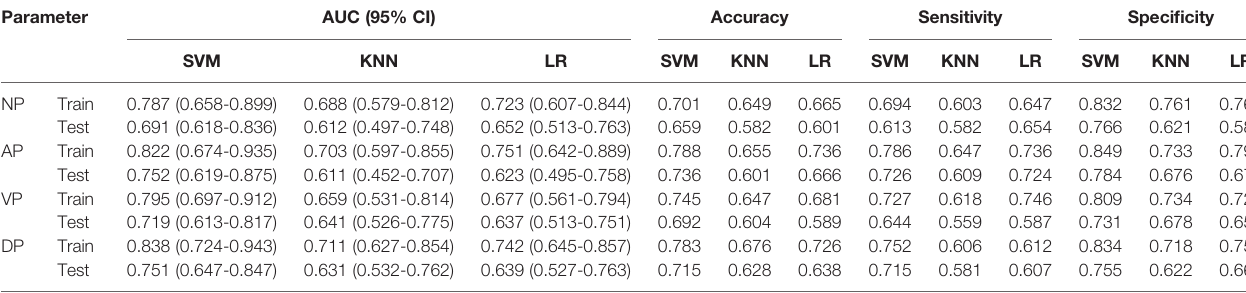
TABLE 2 | ROC curve analysis of different machine models in the training and testing cohorts. Parameter